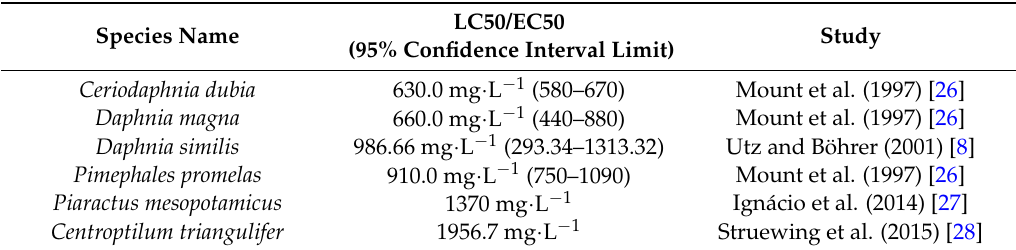
Table 6. Lethal or effective concentration and their confidence intervals (when present, shown in parentheses) for potassium chloride in studies with aquatic